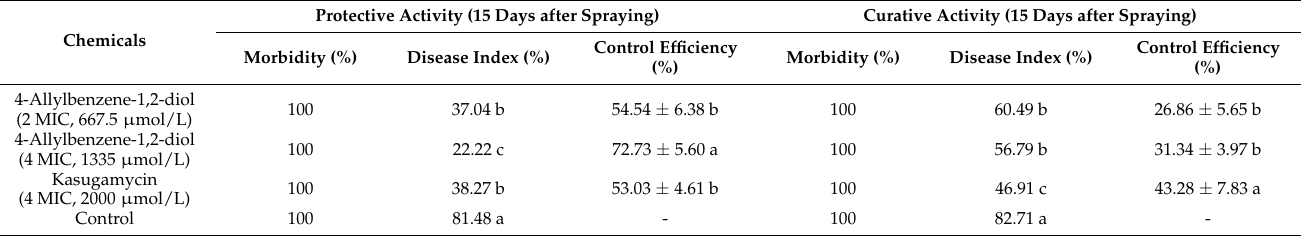
Table 3. Protective and curative activities of 4-allylbenzene-1,2-diol against Xoo.